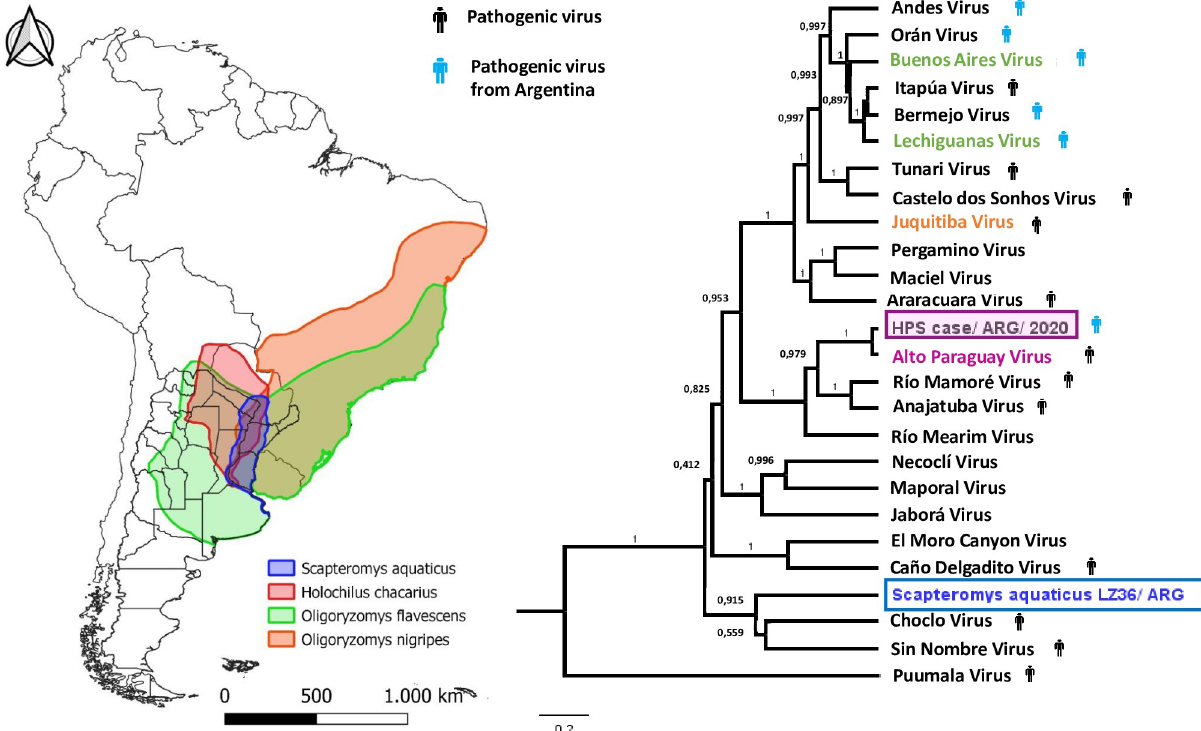
Fig 2. Geographical distribution of reservoir hosts present in the Hantavirus Pulmonary Syndrome endemic area of Central Argentina, and phylogenetic relationships between the viruses characterized here and selected orthohantaviruses from America. In the phylogenetic tree, the viruses present in the area are highlighted according to the color of its reservoir distribution shown in the map. Human figures in black indicate pathogenic viruses, human figures in blue indicate pathogenic viruses identified in Argentina. Map created using QGIS 3.14 Pi (QGIS Development Team); vector layers of the species distribution downloaded from the International Union for Conservation of Nature (IUCN). Phylogenetic relationships among South American Hantavirus genotypes based on Bayesian analysis of 26 taxa dataset of the S-segment partial sequences (283 bp for S . aquaticus and 1,286 bp for the remaining taxa), after 10 million generations. The tree is rooted relative to the position of Puumala virus. The bar represents 0.3 substitutions per nucleotide position. Constructed by BEAST (version 1.10.1) the algorithm MCMC (Metropolis-coupled Markov chain), Branches numbers indicate posterior probability values for the Bayesian